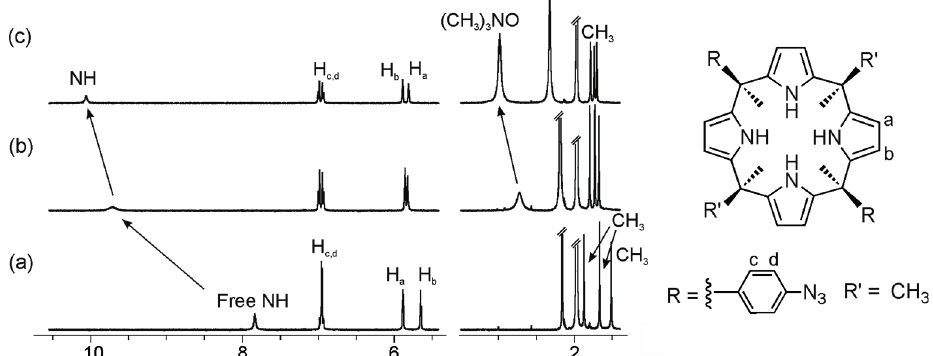
Figure 4. Selected regions of the 1 H-NMR (Proton Nuclear Magnetic Resonance) spectra of a 1.6 mM CD 3 CN solution of calix[4]pyrrole 1c with 0 eq ( a ); 2 eq ( b ); and 8 eq ( c ) of 2a